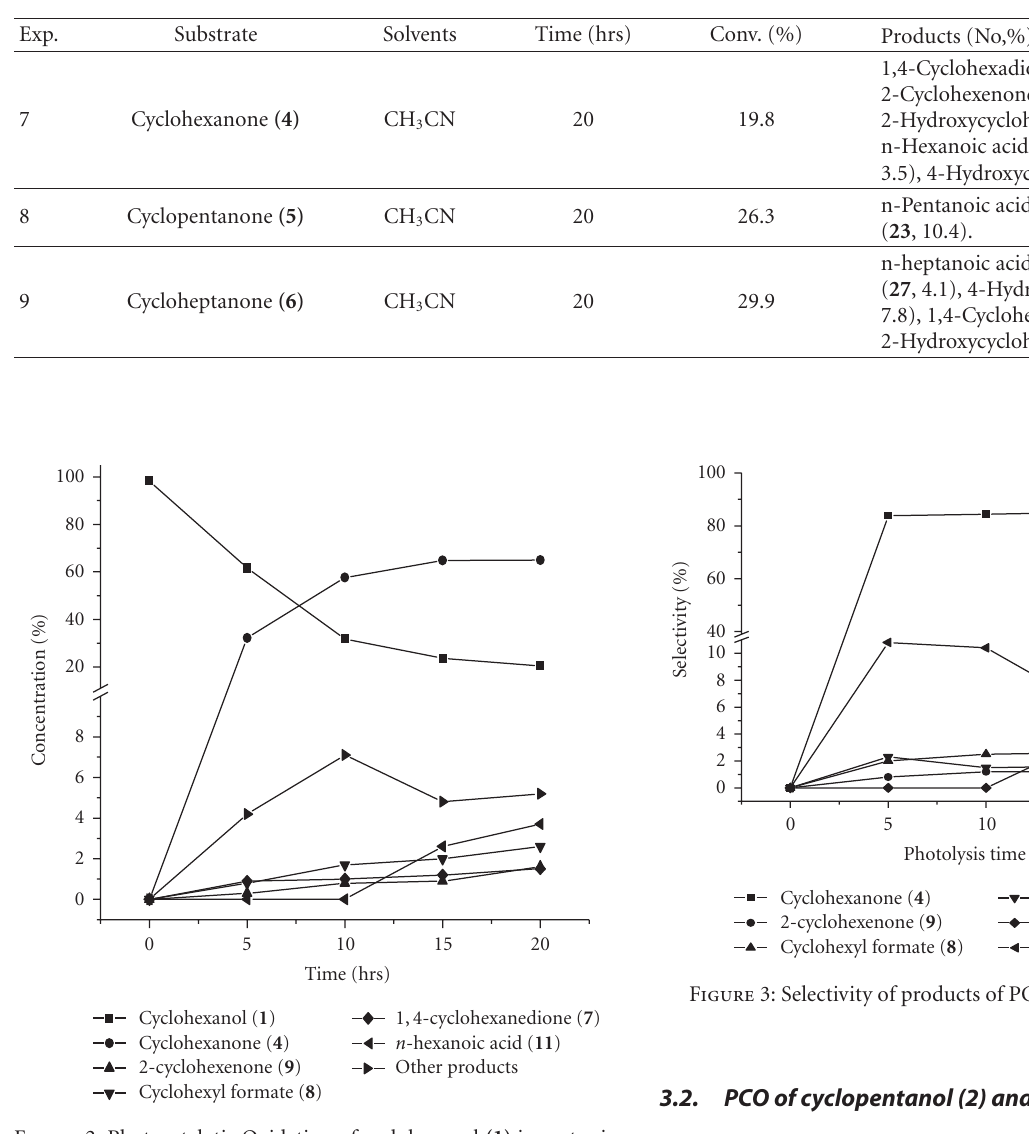
Figure 2: Photocatalytic Oxidation of cyclohexanol (1) in acetoni- trile.